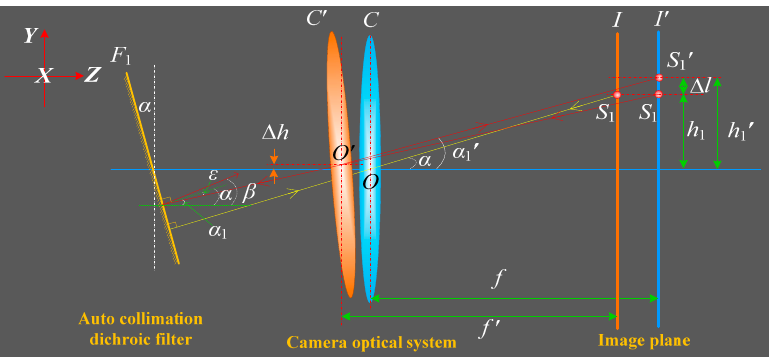
Figure 8. Optical path of one of the differential structures.